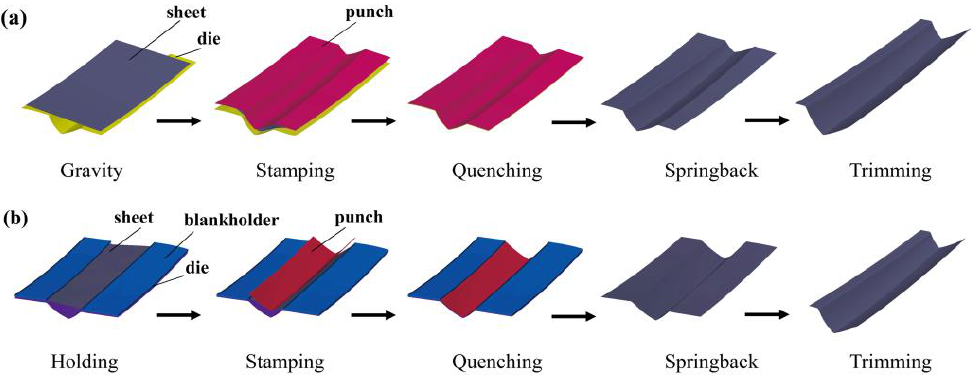
Figure 6. FE simulation procedures for ( a ) hot stamping and ( b ) drawing.